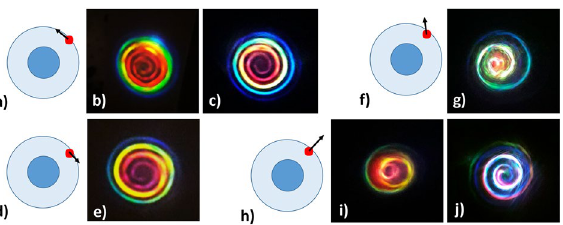
Figure 6. ( a ) Sketch of the input configuration for rainbow spiral emissions obtained in either SI ( b ) or GRIN ( c ) fibres. Black arrows represent the transverse plane components of the input wave vector. ( d ) Symmetric situation with respect to ( a ), leading to flipping the topological charge which results in a change of chirality, as seen in ( e ). ( f , g ) Superposition of two spirals with opposite chiralities and different intensities ( g ) (heart-like spiral emission), when the transverse wave vector has a nonzero radial component ( f ). ( h , i ) Same as in ( f , g ), when the transverse wave vector points along the radial direction. ( j ) Bistable case, resulting in two spirals beam with same chiralities. For all pictures shown, the input power and wavelength were 48 MW and 1030 nm, respectively, and the fibres were 2 cm long. All the images but ( b ) refer to GRIN